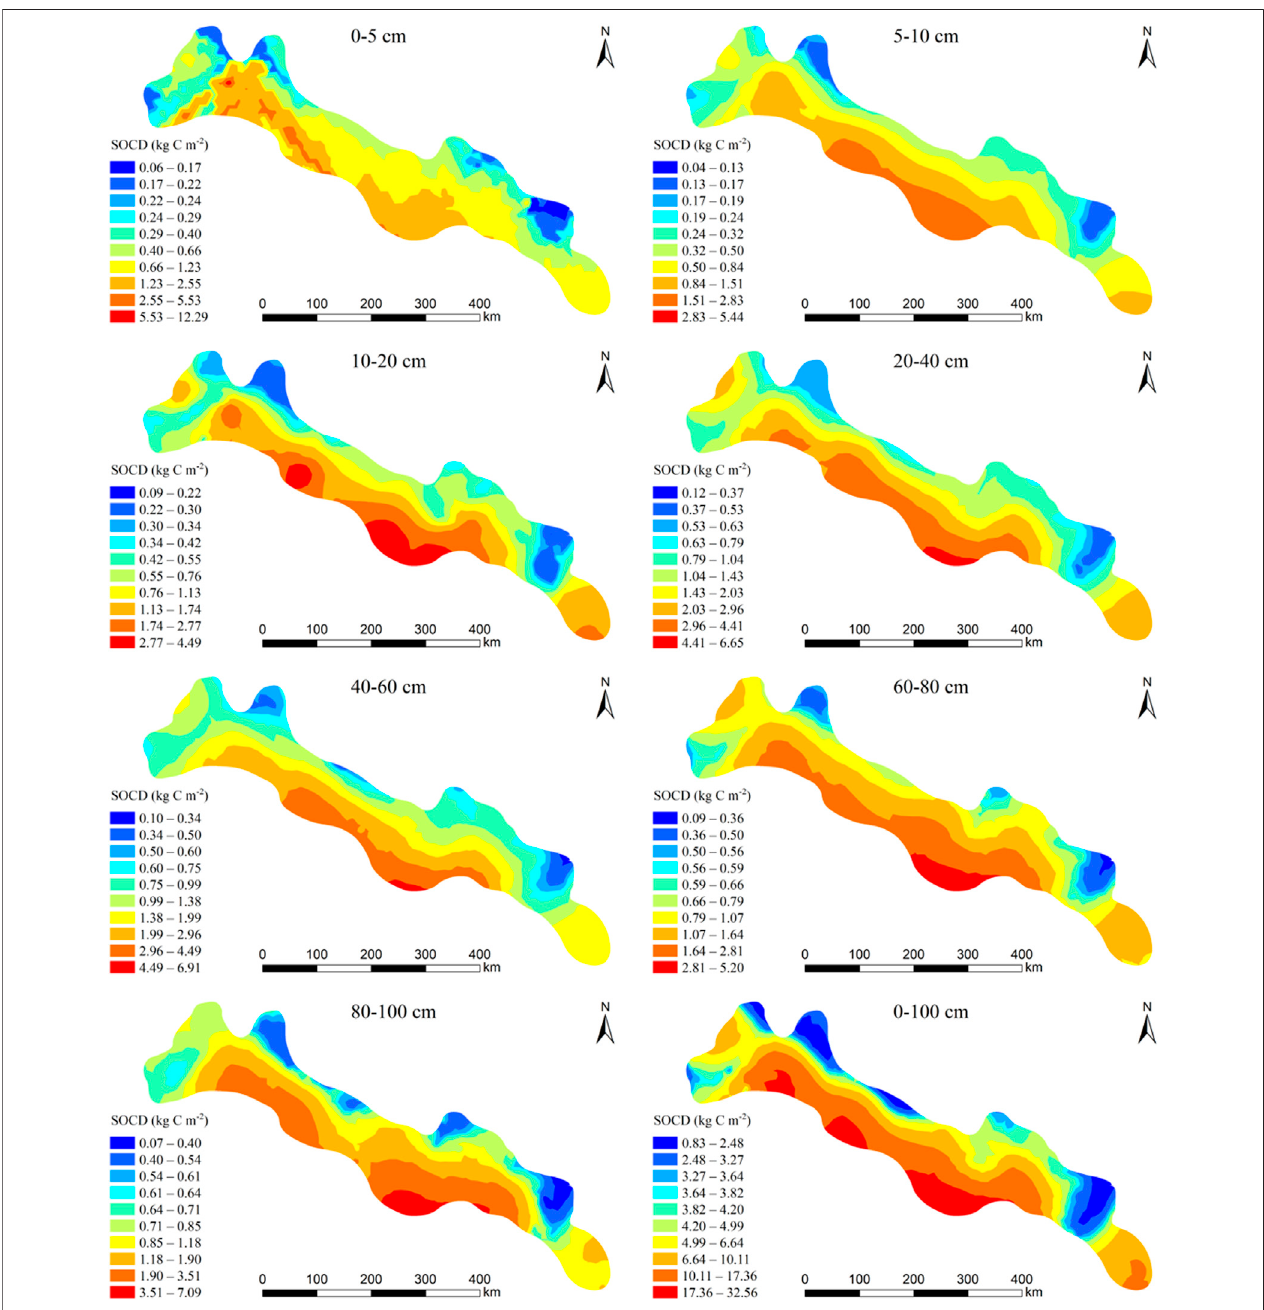
FIGURE 4 | Spatial pattern of soil organic carbon density ( SOCD ) for the different soil layers in the desert steppe area of the Hexi Corridor, in northwestern China. Ranges of SOCD were calculated using the natural breaks method.